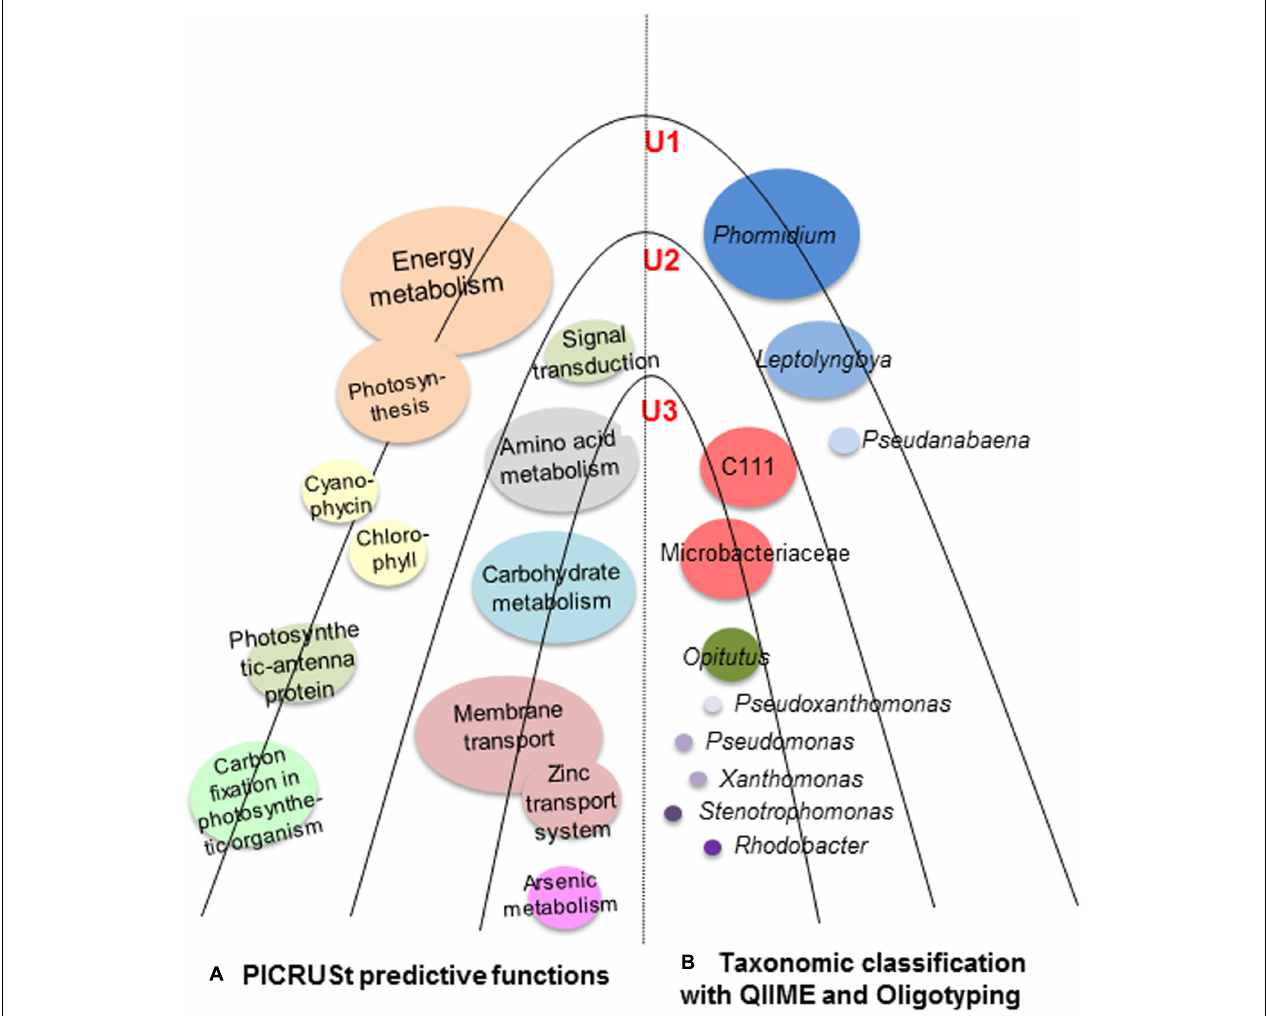
FIGURE 7 | Schematic diagram of U1, U2 and U3 laminae of a large conical mat from Lake Untersee, Antarctica. This diagram shows (A) predicted metabolic functions (PICRUSt) elucidating the metabolism of the carbon, sulfur, and nitrogen in the conical mat; and (B) microbial taxonomic classification of the microbial communities in the conical mat was analyzed by both QIIME and Oligotyping. The U1 lamina was dominated by cyanobacteria, which contributed to high energy metabolism. The U2 and U3 laminae were dominated by heterotrophic bacteria, which were involved in various metabolic activities, particularly membrane transport, amino acid and carbohydrate metabolism. The mean Nearest Sequenced Taxon Index (NSTI) value for all three laminae was 0.11 ± 0.017